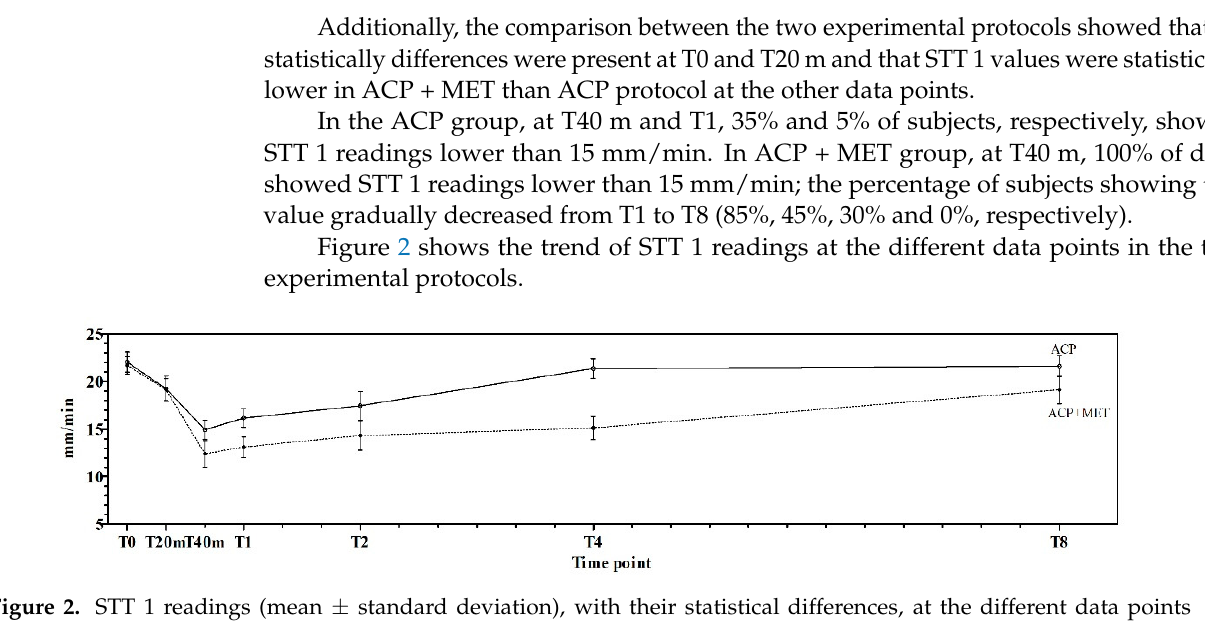
Figure 2. STT 1 readings (mean ± standard deviation), with their statistical differences, at the different data points investigated in the two experimental protocols. ACP indicates the STT 1 values recorded in the group treated with acepromazine. ACP + MET indicates the STT 1 values recorded in the group treated with a combination of acepromazine and methadone.